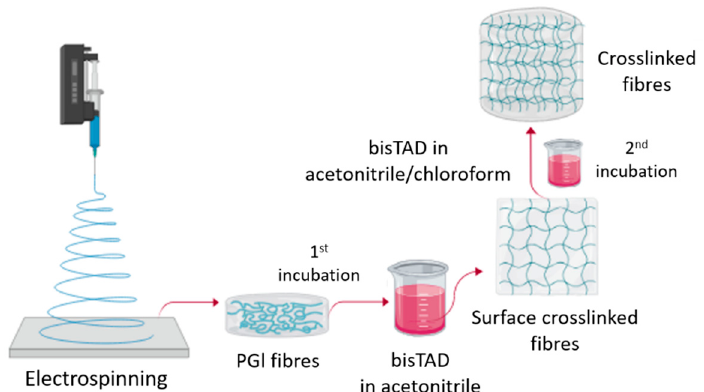
Figure 4. Two-step crosslinking procedure to obtain PGl fibres with different degrees of